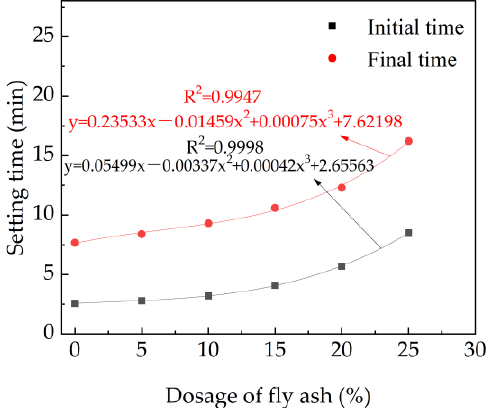
Figure 4. The setting time of fresh cement paste with fly ash.